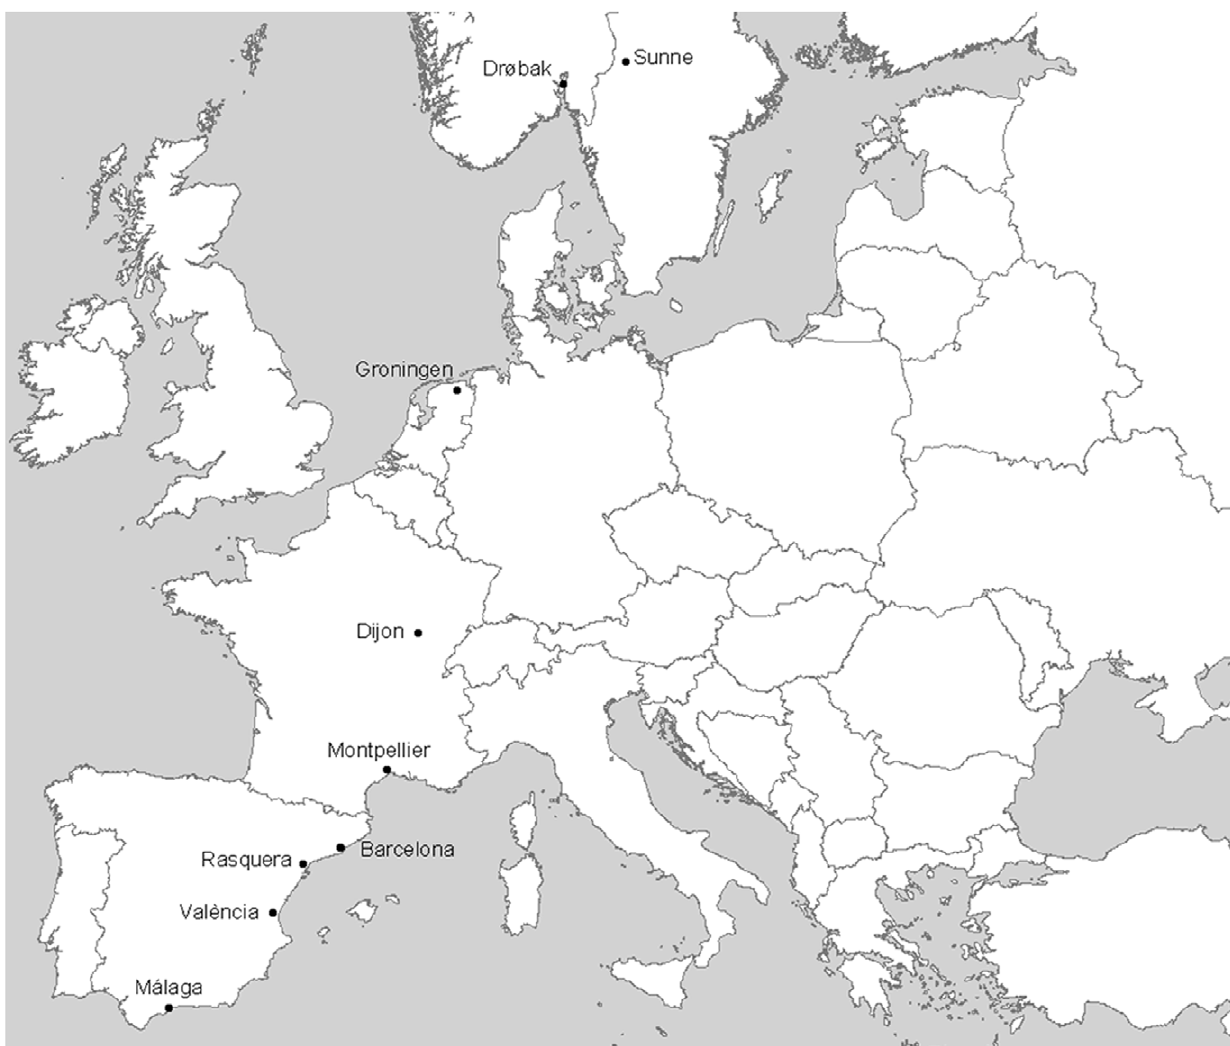
Figure 1. Sampling sites for the D.subobscura populations studied.